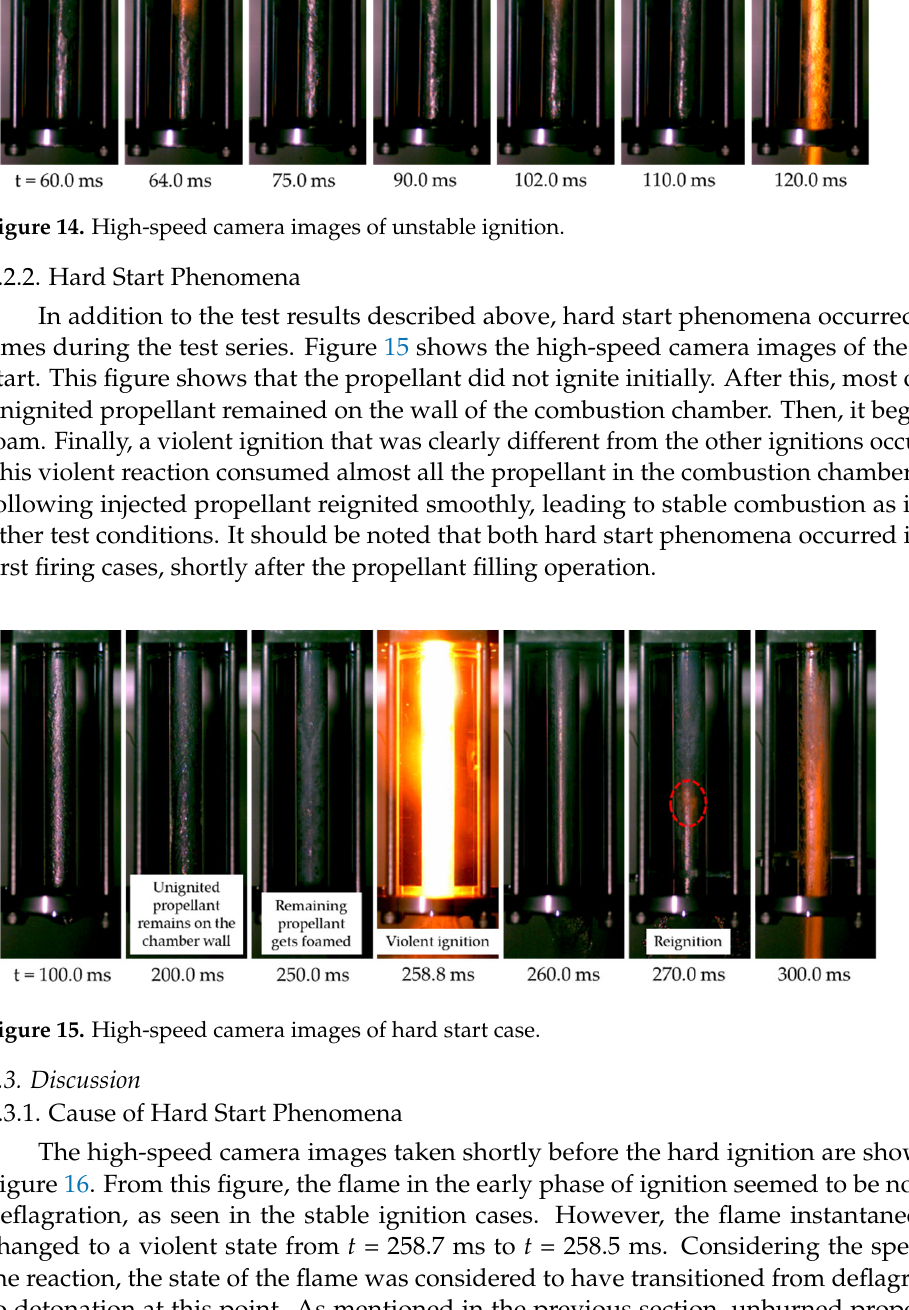
Figure 13. Measured ignition delay in each injection lead time condition (fuel ‐ lead time: negative, oxidizer ‐ lead time: positive).